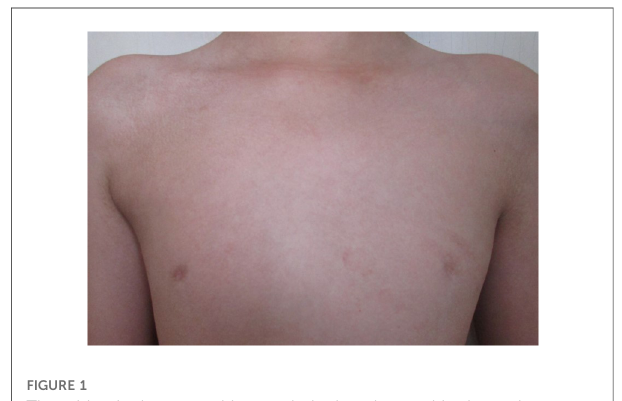
FIGURE 1 The wide nipple gap and inverted nipples observed in the patient.